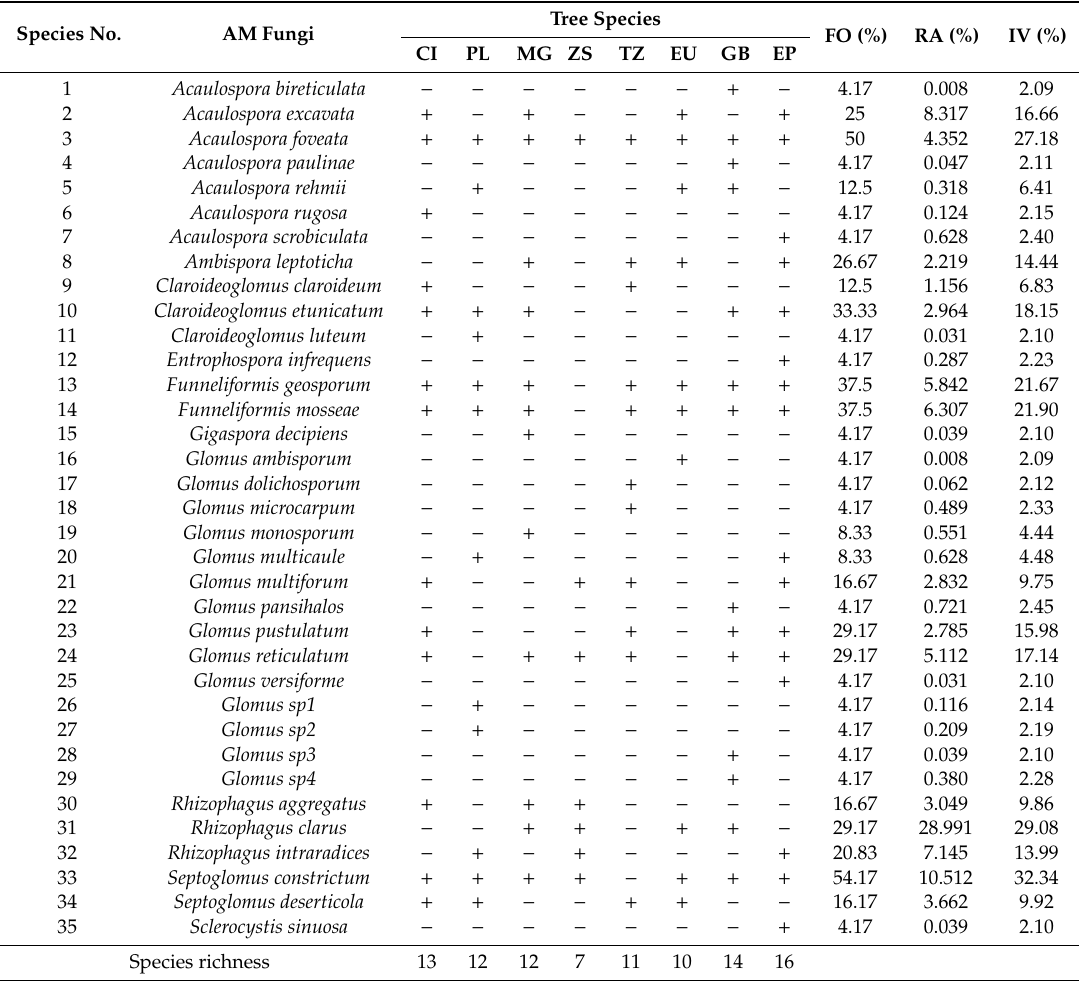
Table 2. Occurrence frequency, relative abundance, and important values of arbuscular mycorrhizal (AM) fungi species for